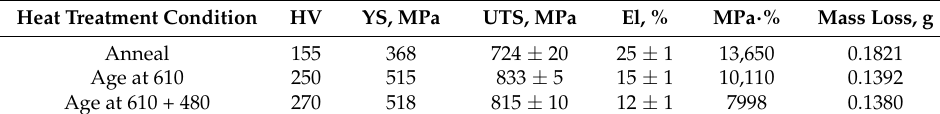
Figure 10. The tensile stress–strain curves of the Monel K500 plate. Table 4. The mechanical properties of the Monel K500 plate.